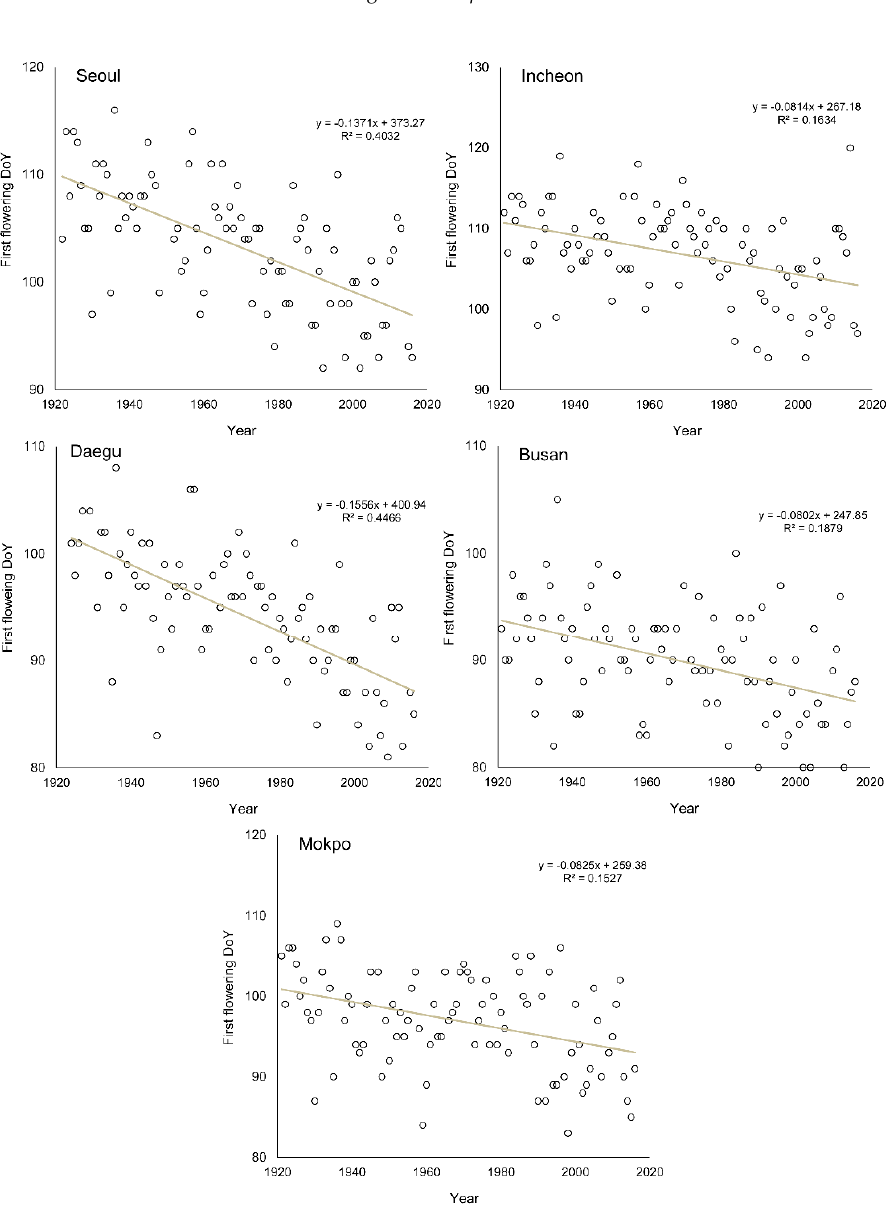
Figure 8. Changes of the first flowering DoY of cherry during the past century in major cities of South Korea.